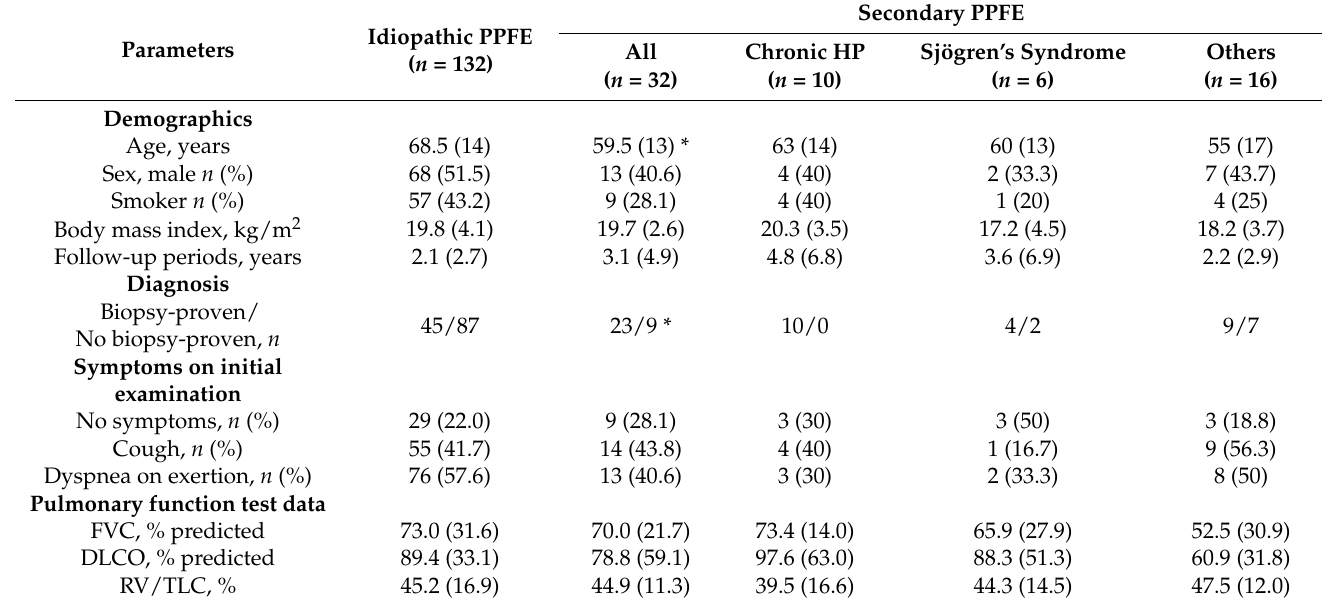
Table 2. Comparison of the baseline characteristics between idiopathic and secondary